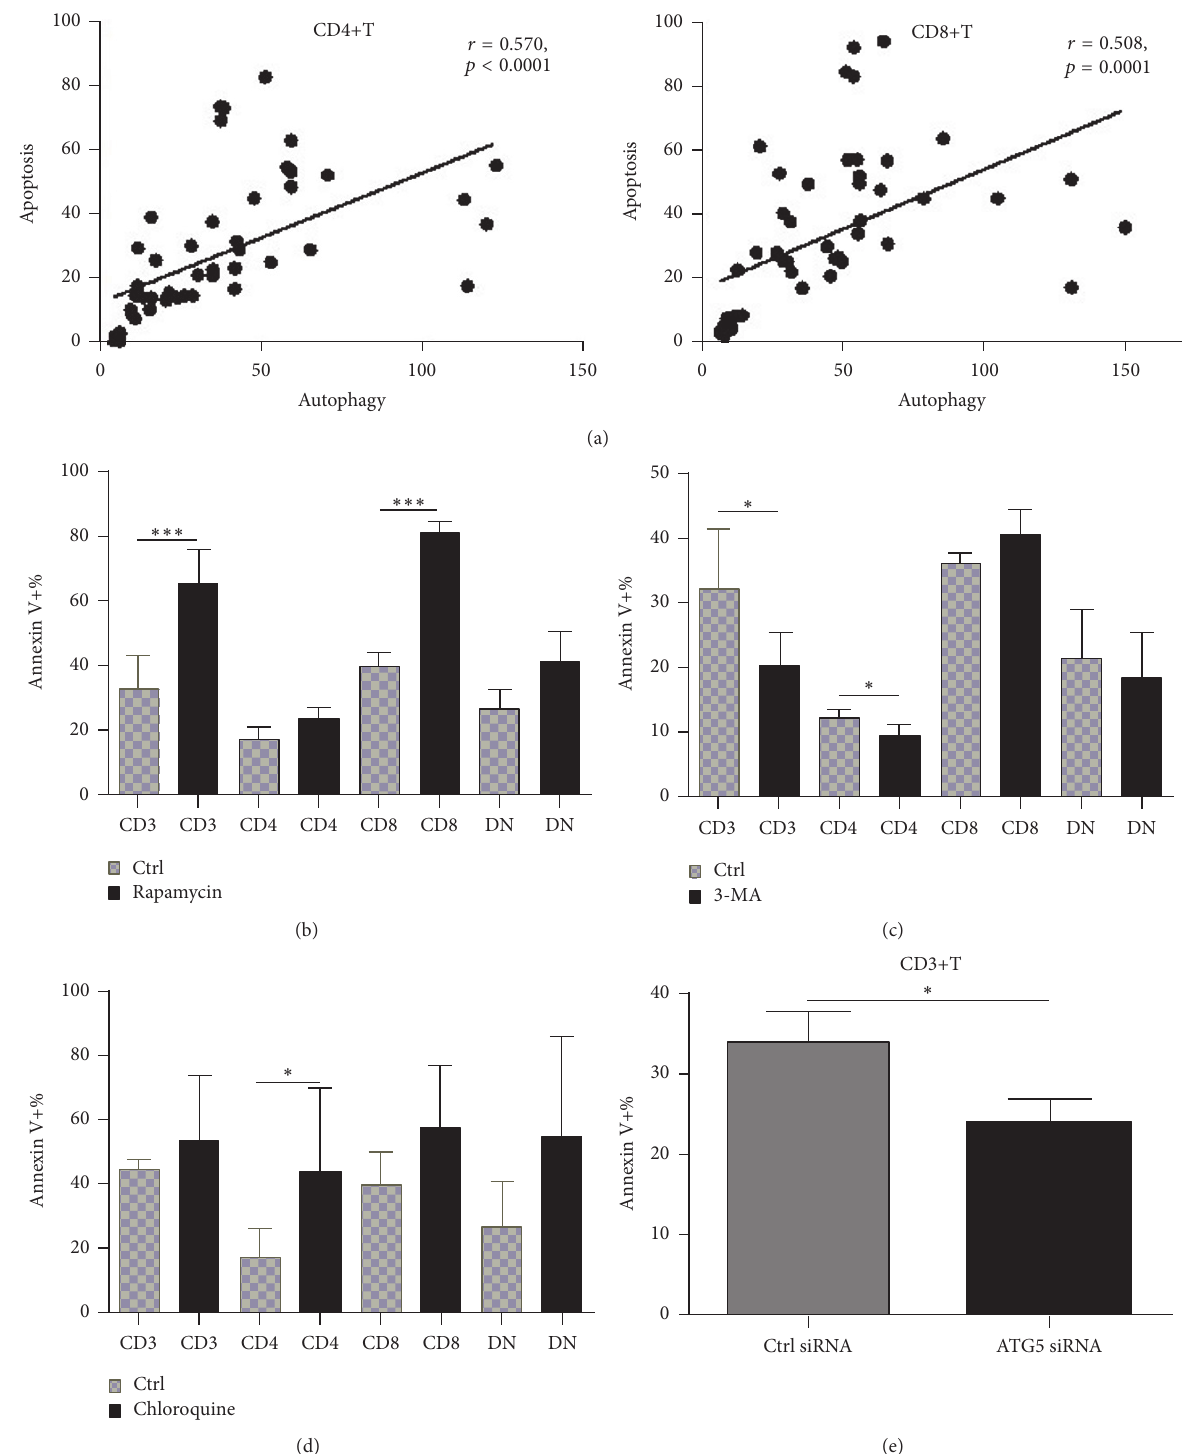
Figure 3: T cells with increased autophagy following stimulation were prone to apoptosis. Autophagy and apoptosis of T cells from SLE patients were detected after stimulation with anti-CD3/C28 antibodies for different time. And their correlation was analyzed. Apoptosis was also measured after autophagy activation with rapamycin (50ng/mL, 72 h, simultaneously with anti-CD3/28 stimulation), or suppression with 3-methyladenine (3-MA) (5 mM, 6h, following anti-CD3/28 stimulation for 48 h) or chloroquine (CQ, 50 𝜇 M for 24h, following anti- CD3/28 stimulation for 48h). In vitro experiments were performed in triplicate. (a) Correlation of apoptosis of both CD4+T and CD8+T cells from SLE patients with autophagy level following anti-CD3/28 stimulation ( 𝑛 = 32 ). (b) Activation of autophagy with rapamycin further promote apoptosis of T cells, especially in CD8+T cells ( 𝑛 = 7 ). (c) Suppression of autophagy with 3-MA rescued T cells (mainly CD4+T) from apoptosis ( 𝑛 = 7 ). (d) Treatment with chloroquine increased apoptosis of CD4+T cells ( 𝑛 = 6 ). (e) ATG5 silencing decrease apoptosis of T cells significantly. ∗ 𝑝 < 0.05 ; ∗∗∗ 𝑝 < 0.001